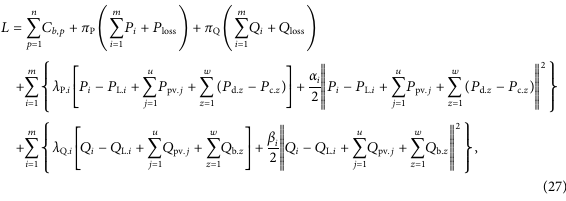
FIGURE 6 Two-layer optimization scheduling solution